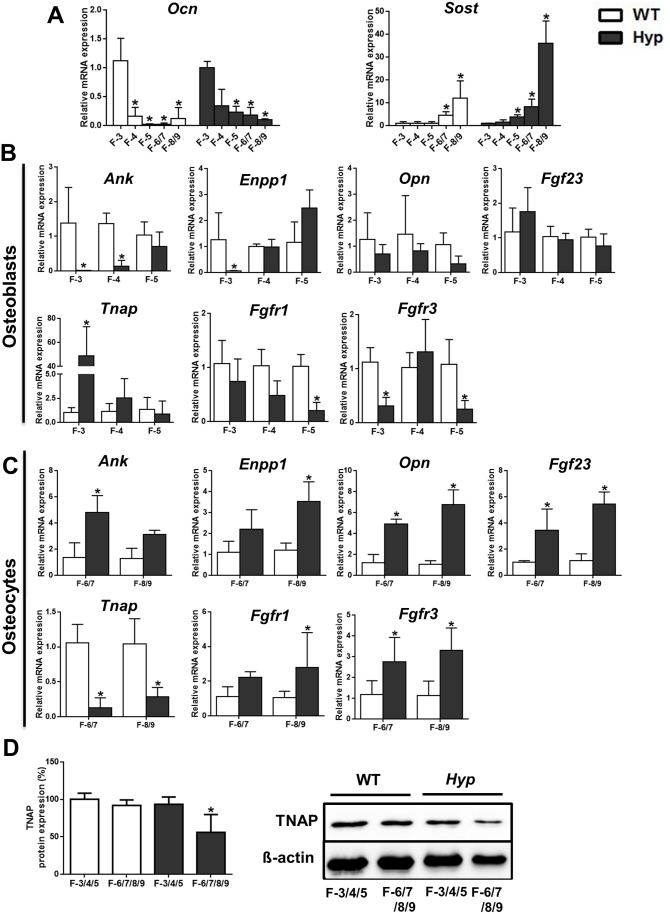
Osteocyte-rich cell fractions isolated from Hyp femurs show increased mRNA expression of PPi-regulating genes and decreased mRNA expression of Tnap ex vivo.
(A) mRNA abundance of the osteoblast-specific gene Ocn and of the osteocyte-specific gene Sost in total RNA isolated from cell fractions harvested by sequential digestion from femurs of 3-mo-old male WT and Hyp mice. (B–C)
Ank, Enpp1, Opn, Fgf23, Tnap, Fgfr1, and Fgfr3 mRNA abundance in total RNA isolated from osteoblast-rich fractions F-3 to F-5 (B) and from osteocyte-rich fractions F-6/7 to F-8/9 (C) harvested by sequential digestion from femurs of 3-mo-old male WT and Hyp mice. (D) TNAP protein expression in pooled osteoblast- and osteocyte-rich fractions harvested by sequential digestion from femurs of 3-mo-old male WT and Hyp mice. Each data point is the mean ± SD of four samples from four different mice. Individual values are given in S1 Data. *, p < 0.05 versus F-3 in A; *, p < 0.05 versus WT in B–C; *, p < 0.05 versus WT F-3/4/5 in D.